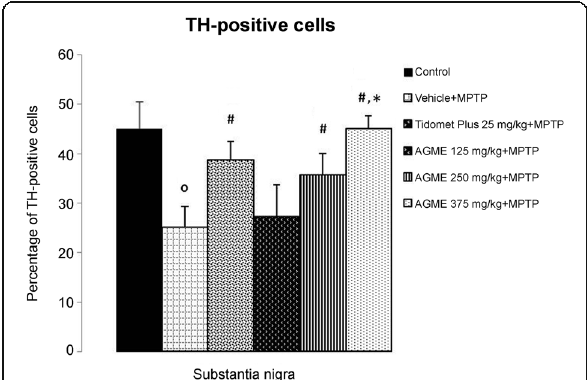
Fig. 7 The effect of AGME on the number of TH-immunopositive neu- rons in the substantia nigra after MPTP administration. The numbers of TH-positive neurons are expressed as the mean±S.D., ( n =4/group), o - p <0.01 compared with the control group; #- p <0.05 compared with the MPTP/vehicle treatment group, *- p <0.05 compared to the Tidomet Plus+MPTP treatment